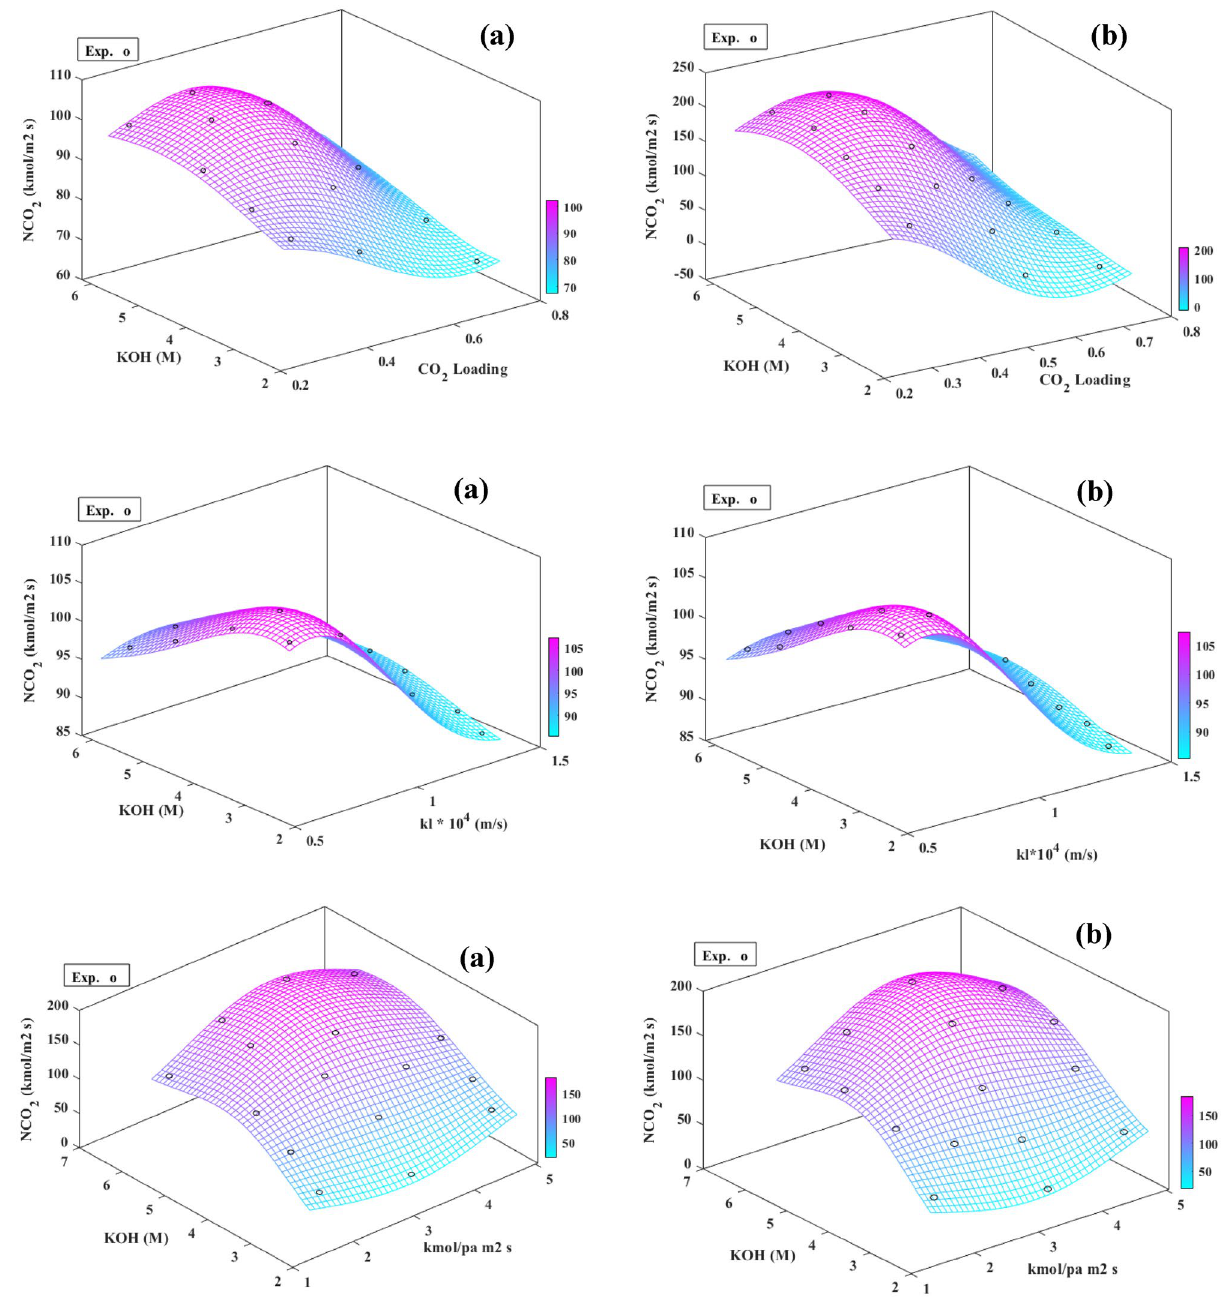
Figure 9. Response surfaces plot artificial neural networks of the MLP ( a ) and RBF ( b ) models for the prediction of flux absorption ( N CO2